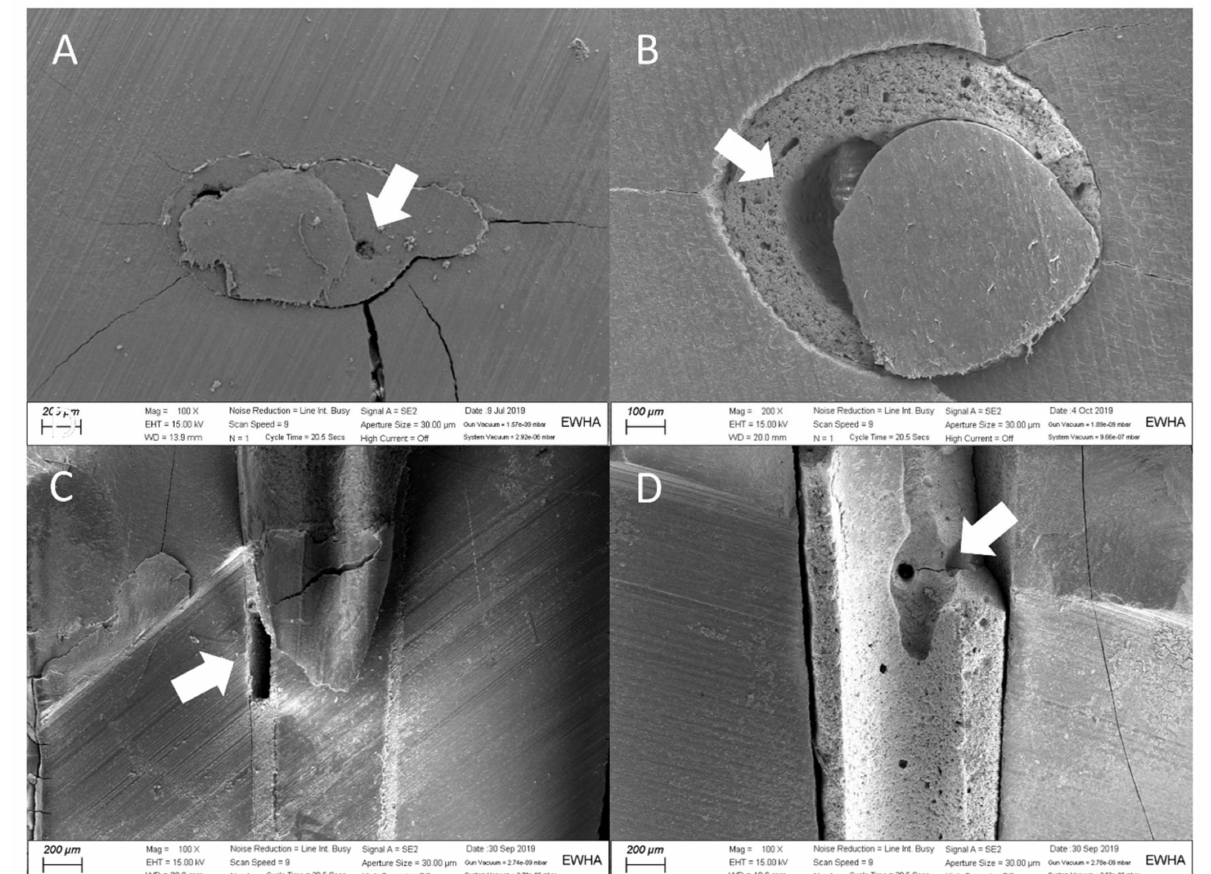
Figure 3. SEM images showing interfacial gaps and voids (arrows): ( A ) 100 × horizontal section of EndoSequence BC sealer with the single-cone technique (SC group), ( B ) 200 × horizontal section of EndoSequence BC sealer with the single-cone technique (SC group), ( C ) 100 × sagittal section of AH Plus with the continuous-wave technique (CW group), and ( D ) 100 × sagittal section of EndoSequence BC sealer with the single-cone technique (SC